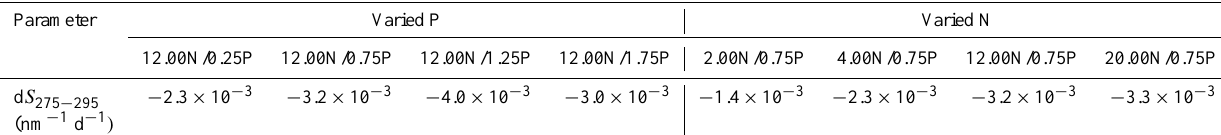
Table 2. Estimated linear change (per day) of spectral slope parameter (d S 275 − 295 ) for replicated treatments.